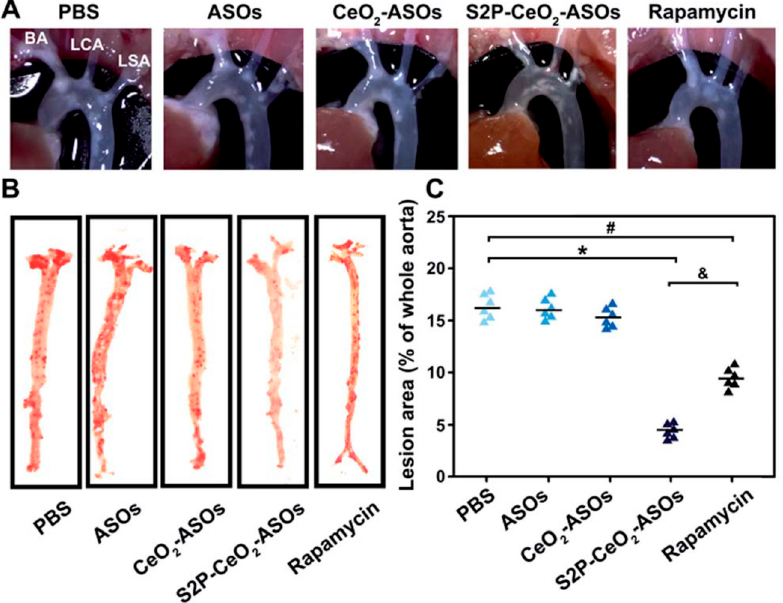
Figure 4. ( A )The atherosclerosis efficacy of indicated materials following intravenous administra- tion into ApoE − / − mice Representative images of the in situ aortic arch lesions at the brachiocephalic artery (BA), left carotid artery (LCA), and left subclavian artery (LSA). ( B ) Representative images of oil red O-stained en face aorta. ( C ) The lesion area as a percentage of the whole aorta. * P < 0.05 for S2P-CeO2-ASOs vs. PBS, # P < 0.05 for rapamycin vs. PBS, & P < 0.05 for S2P-CeO2-ASOs vs. rapamycin. Adapted from [105].